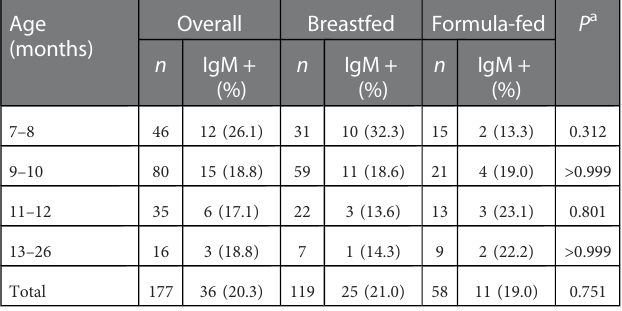
TABLE 3 Seroprevalence of cytomegalovirus (CMV) IgM in breast- and formula-fed infants with positivity of CMV IgG.